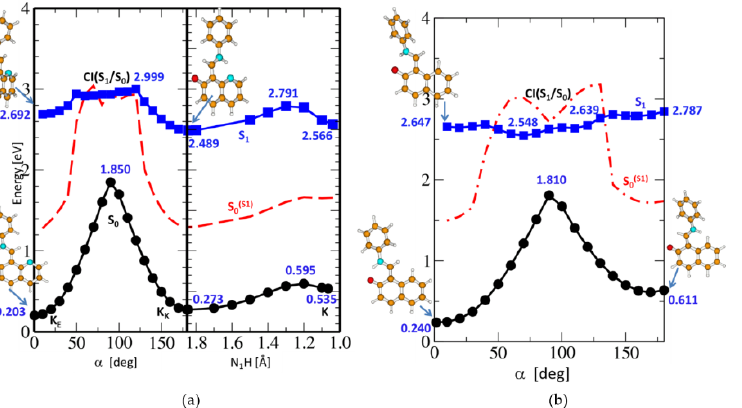
Figure 2. Relaxed potential energy scans of 1 ( a ) and 3 ( b ) in the S 0 state (circles), determined at the MP2/cc-pVDZ theory level in the S 1 state (blue squares), determined at the ADC(2)/cc-pVDZ theory level along the minimum potential energy path for N-phenyl crane torsion ( K E to K K , α coordinate), and for hydrogen transfer from the intermediate form K K , toward terminal form K (N 1 H coordinate). S 0(S1) denotes the energy of the S 0 state, calculated at the geometry of the S 1 excited state (red dashed curves). Adiabatic energies (in blue), E a , in eV.